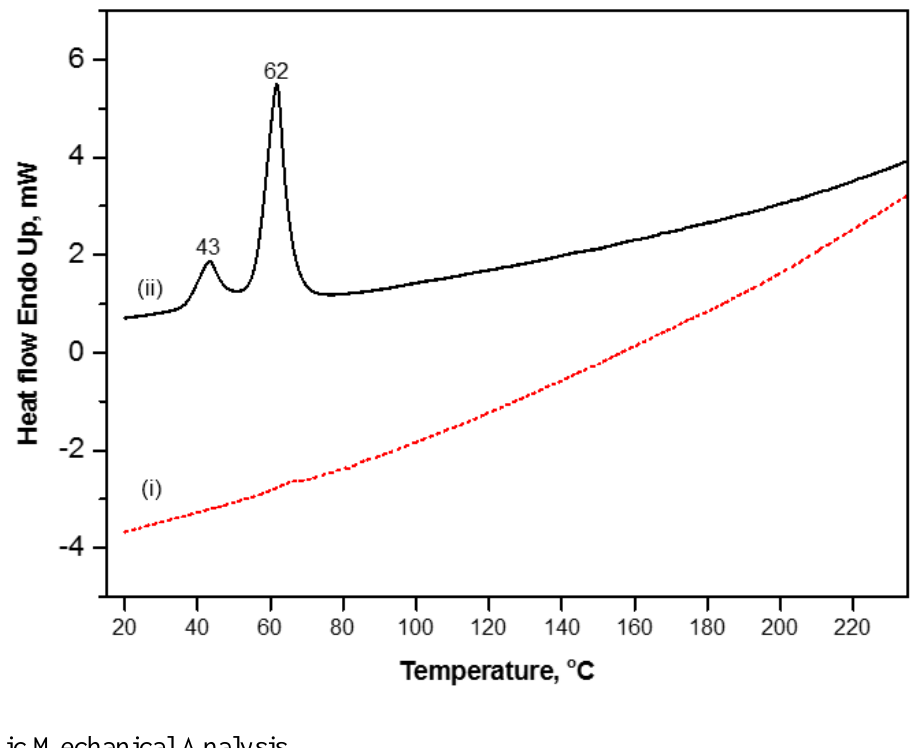
Figure 3. Differential Scanning Calorimetry of (i) unmodified MFC and (ii) modified MFC, curves are shifted along Y-axis to have the better